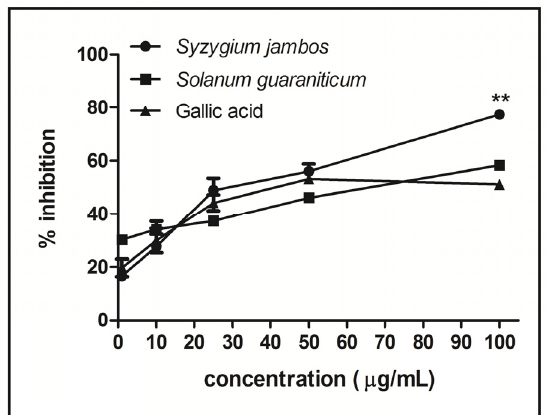
mean ± SEM ( n = 3) and assessed by one way ANOVA followed by Duncan Multiple Comparison post hoc test. ** denotes p < 0.001 compared to Solanum guaraniticum and gallic acid (100